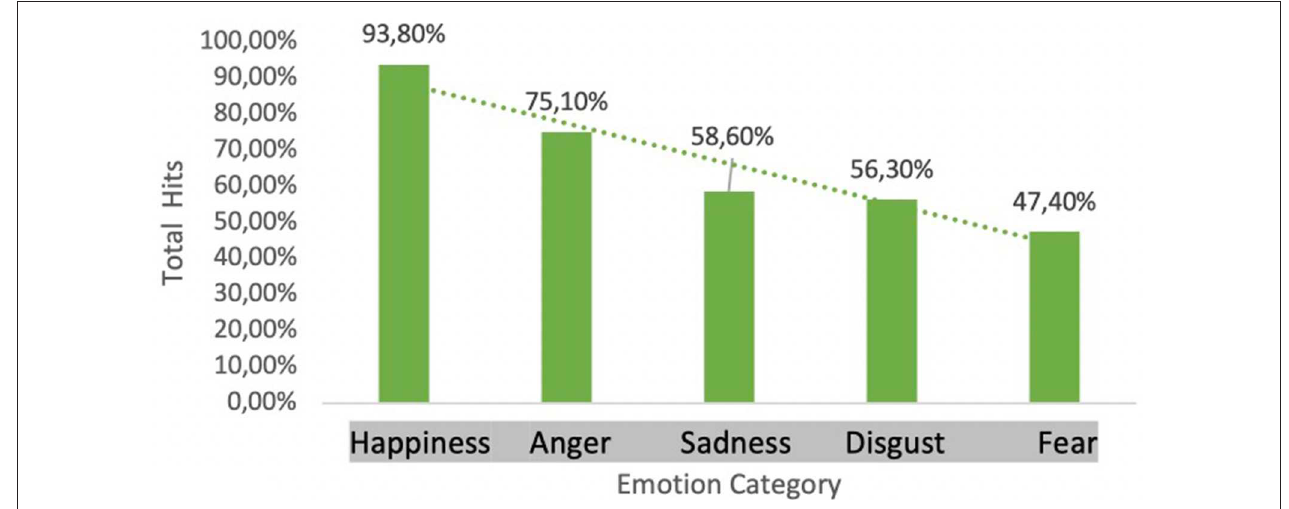
FIGURE 6 | Average percentage of correct answers by emotion category.